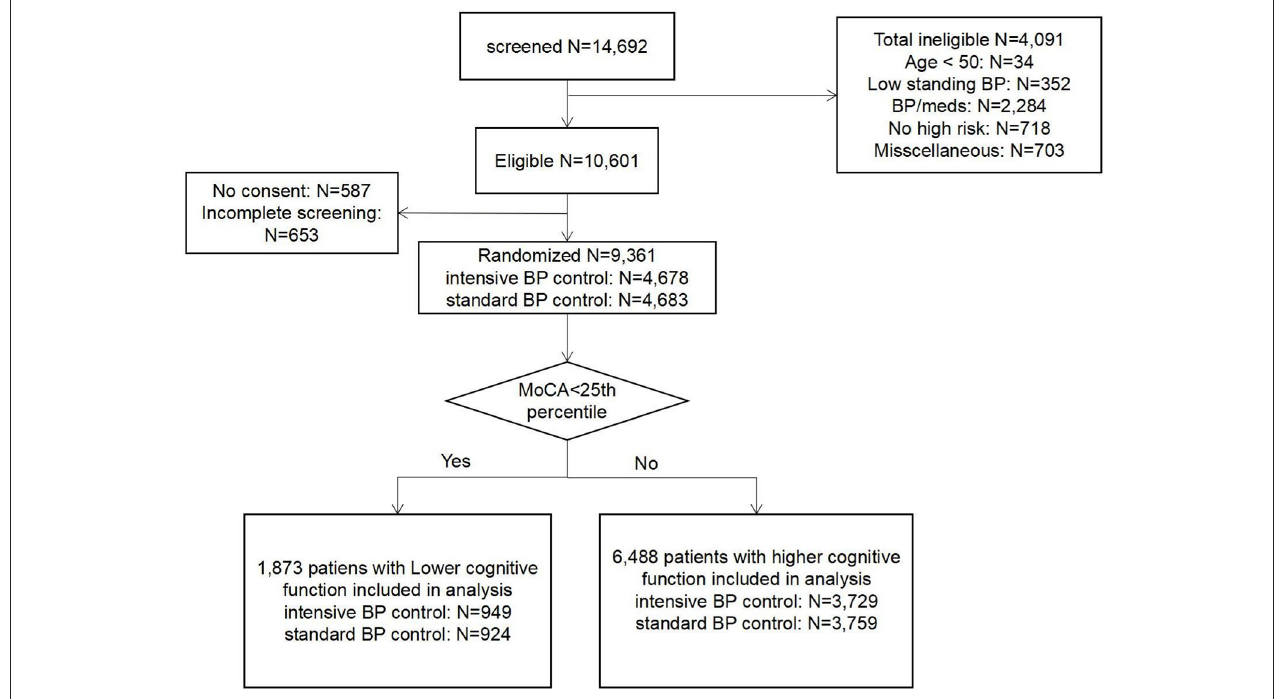
FIGURE 1 | The flow diagram of the study. BP/meds: systolic blood pressure were out of range/ taking too many medications.